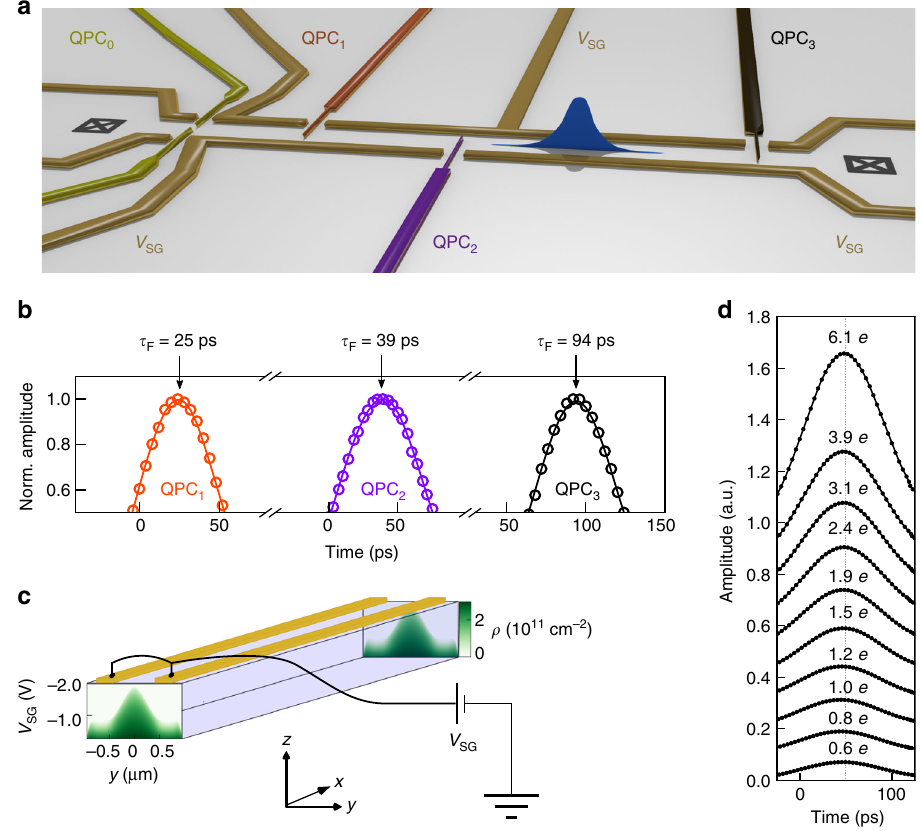
Fig. 1 Device and time-of- fl ight measurements. a Schematic of the quantum device. A few-electron pulse is launched at the left ohmic contact (black crossed box) by applying a very short ( ≈ 70 ps) voltage pulse. Three QPCs, denoted as QPC 1 , QPC 2 and QPC 3 , are placed along the quantum device at a distance of 15, 30 and 70 μ m from the left ohmic contact. Each of these three QPCs is connected to a large bandwidth (40 GHz) bias tee and operated as an ultrafast switch. Time-resolved detection of current is done at the right ohmic contact. QPC 0 , placed a distance of 6 μ m from the left ohmic contact, is used as a channel selection. b Time-resolved measurements of an electron pulse at the three different QPC positions. c Illustration of the sample geometry used for the self-consistent calculations. The quasi one-dimensional quantum wire is de fi ned by the two long electrostatic gates at potential V SG . The coloured images, one at the beginning of the wire and another one at the end, are cross-sections of the electron density pro fi le along the y -axis as a function of the gate voltage. d Time-resolved measurements of an electron pulse at QPC 3 for different excitation amplitudes. The amount of electrons contained in the electron pulse is varied between 0.6 e and 6.1